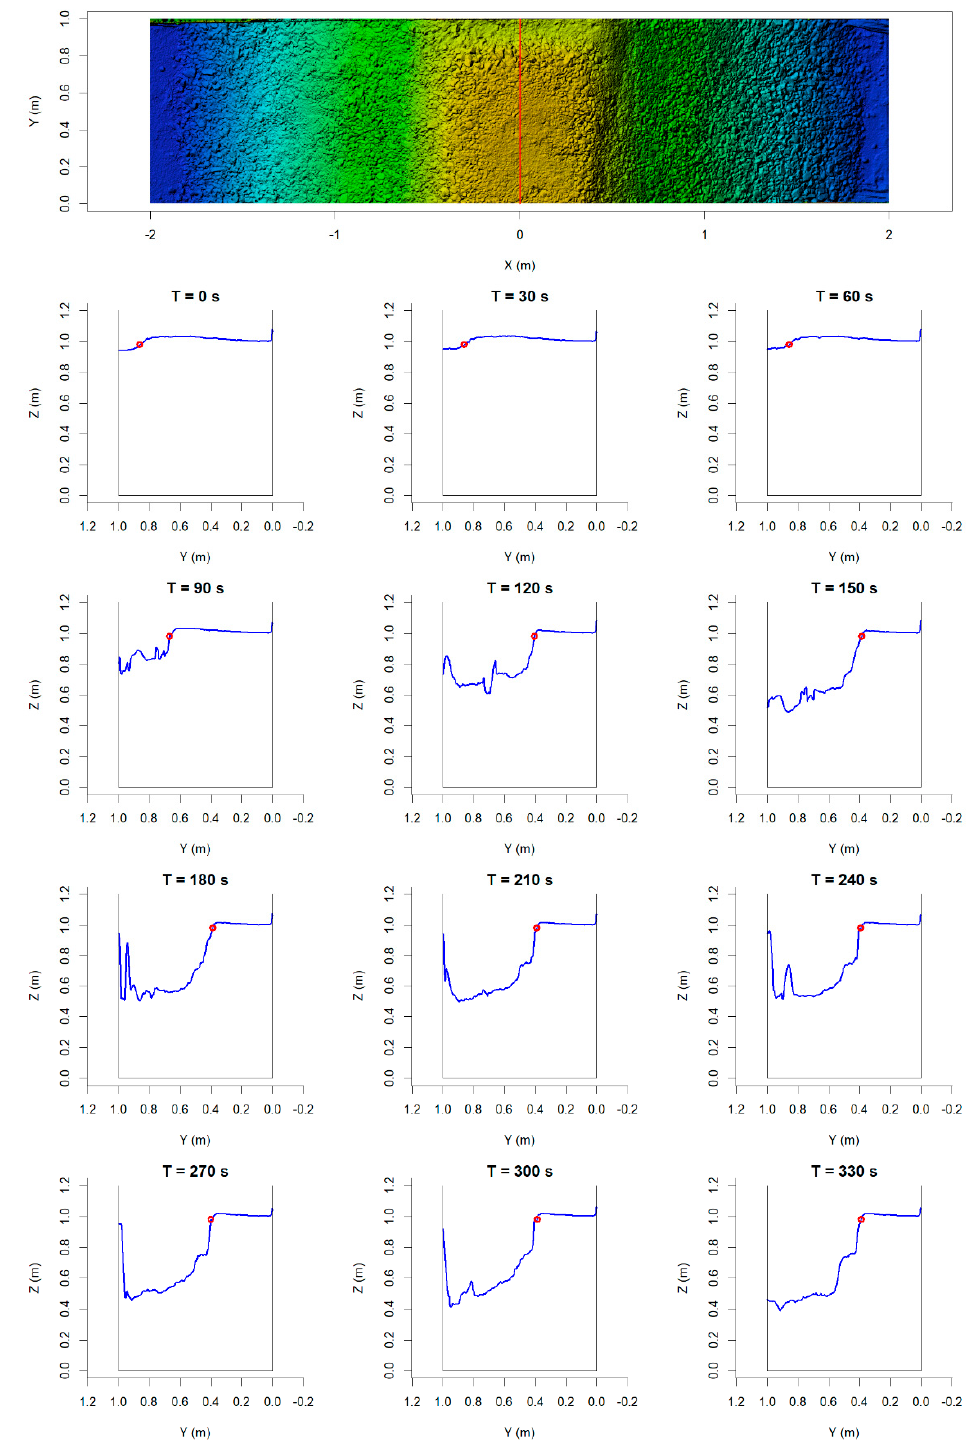
Figure A5. Cross-section profiles for X = 0 m (centre line) extracted from U5 dynamic 3D model; T = 0 s is immediately before initial observed erosion at downstream edge of crest; red circle indicates breach edge as used in further analyses.